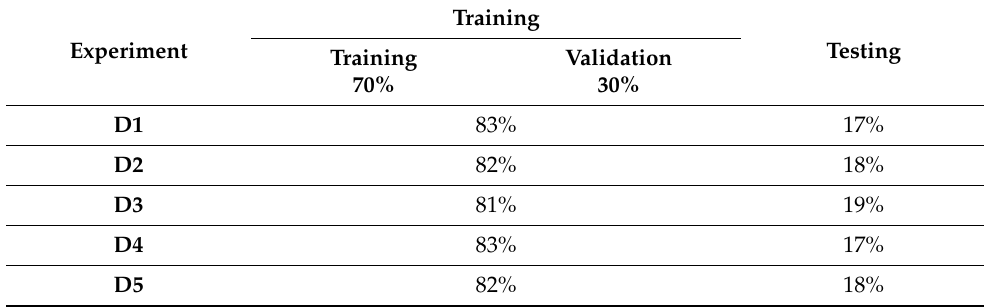
Table 10. RG Drone Audio Dataset.